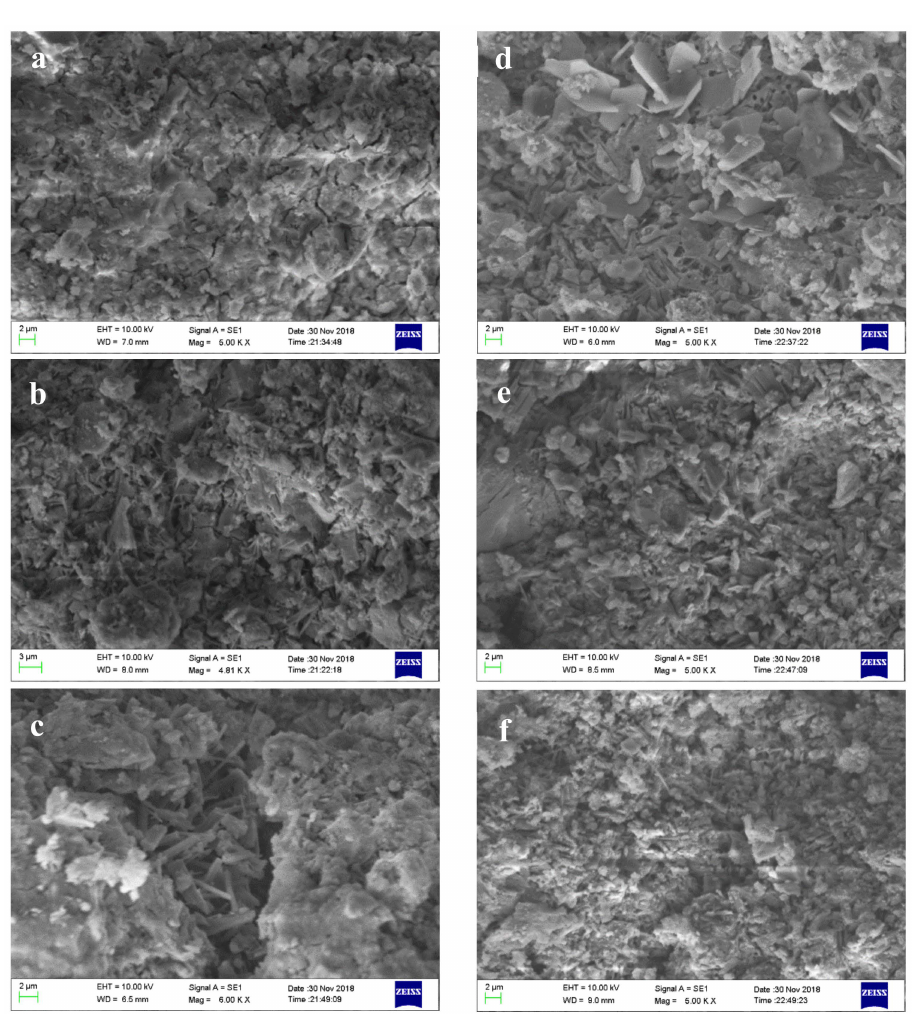
Figure 9. SEM pictures of AMCSA hydration for 1 day and 28 days. Note: ( a – c ) are SEM pictures of specimen A1, A4 and A6 at 1 day, and ( d – f ) are SEM pictures of specimens A1, A4 and A6 at 28 days